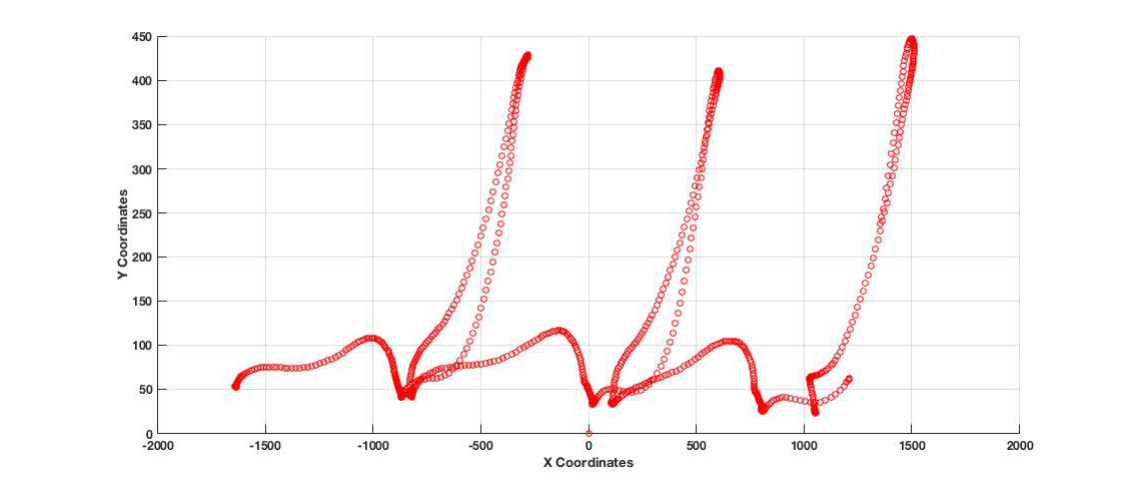
Figure 15. The coordinates of the trajectory of the left foot joint, which shows the rhythm of the dance performed by dancer